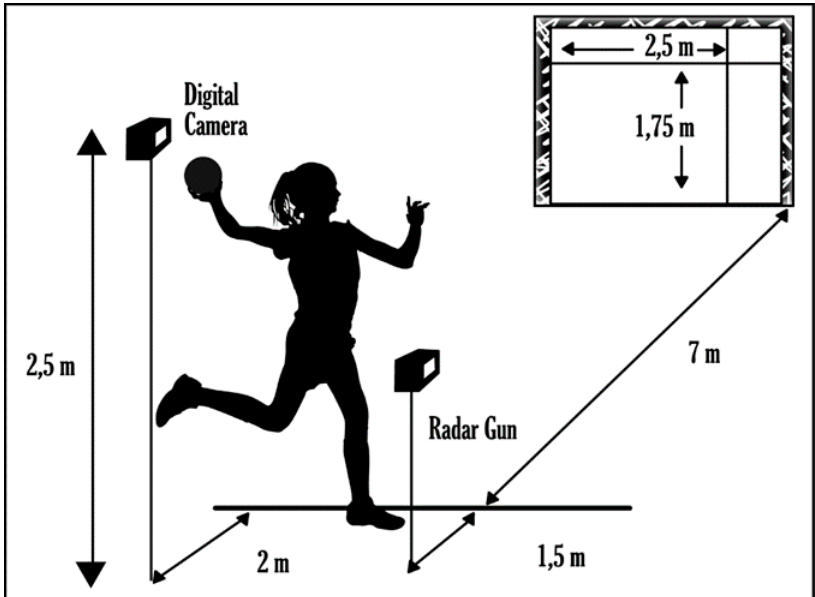
Figure 1. Graphical representation of the ball throwing task.